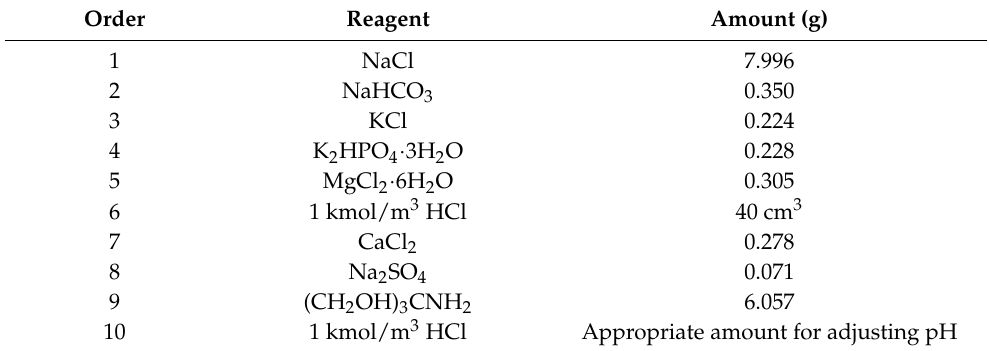
Table 1. The order of chemicals for the simulated body fluid (SBF) preparation.